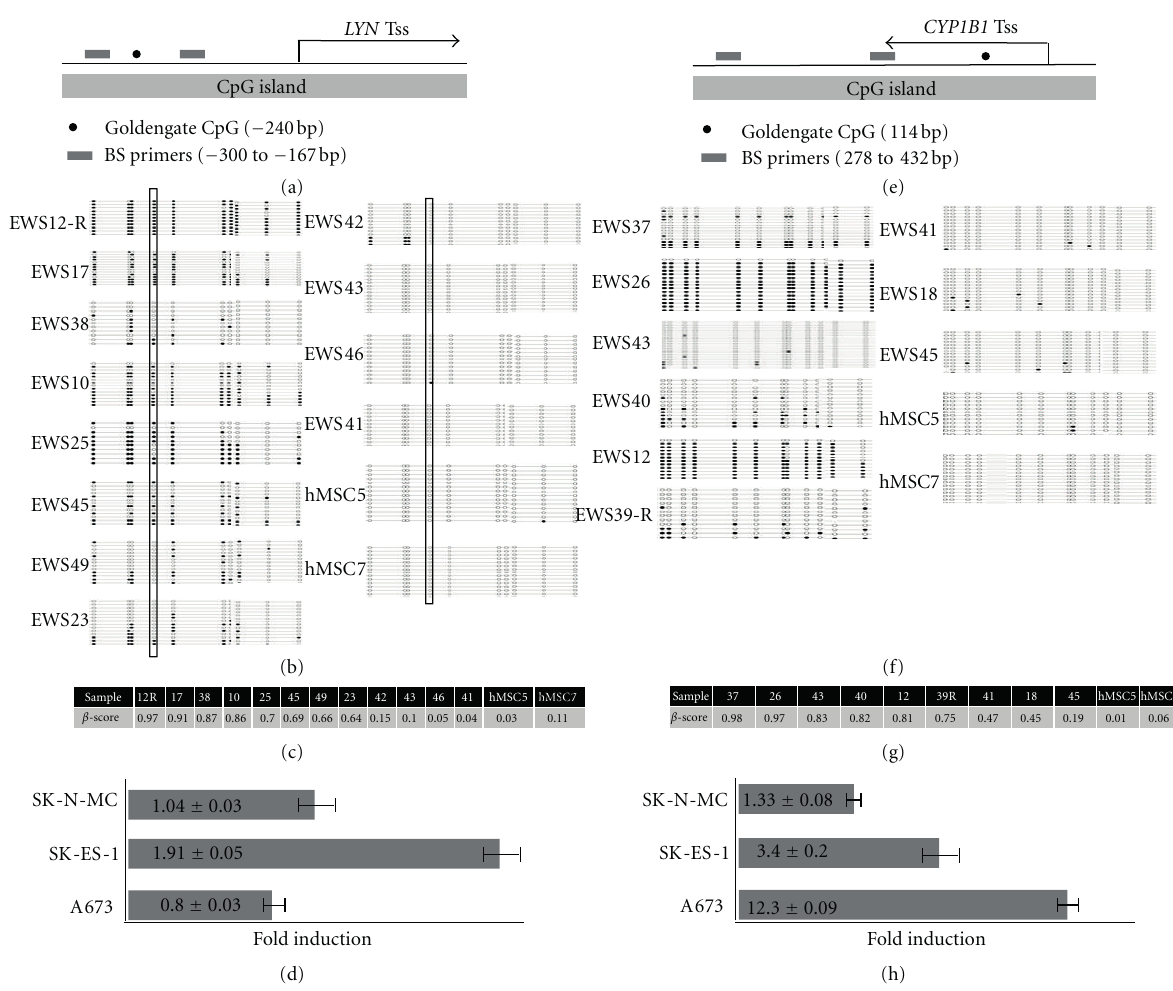
Figure 5: LYN and CYP1B1 methylation analysis. (a) Schematic diagram of LYN showing the location of the Tss in relation to the CpG island, bisulfite sequencing primers, and the CpG analyzed by beadchip assay. (b) Bisulfite sequencing of LYN in EWS primary tumors and hMSCs. (c) Bead chip β scores for each sample shown. (d) qRT-PCR for LYN in EWS cell lines with or without 5-AZA treatment. Error bars demonstrating the standard error of the mean (SEM) are shown. (e) Schematic diagram of CYP1B1 . (f) Bisulfite sequencing of CYP1B1 in EWS primary tumors and hMSCs. (g) Bead chip β scores for CYP1B1. (h) qRT-PCR for CYP1B1 in EWS cell lines with or without 5-AZA